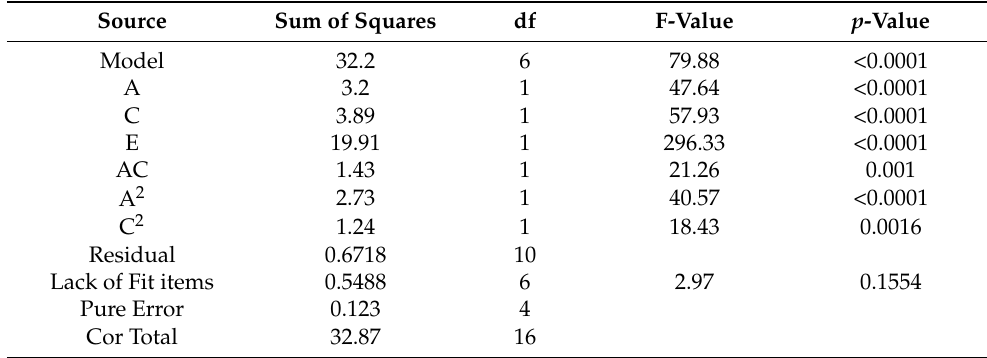
Table 8. ANOVA of modified model of Box-Behnken